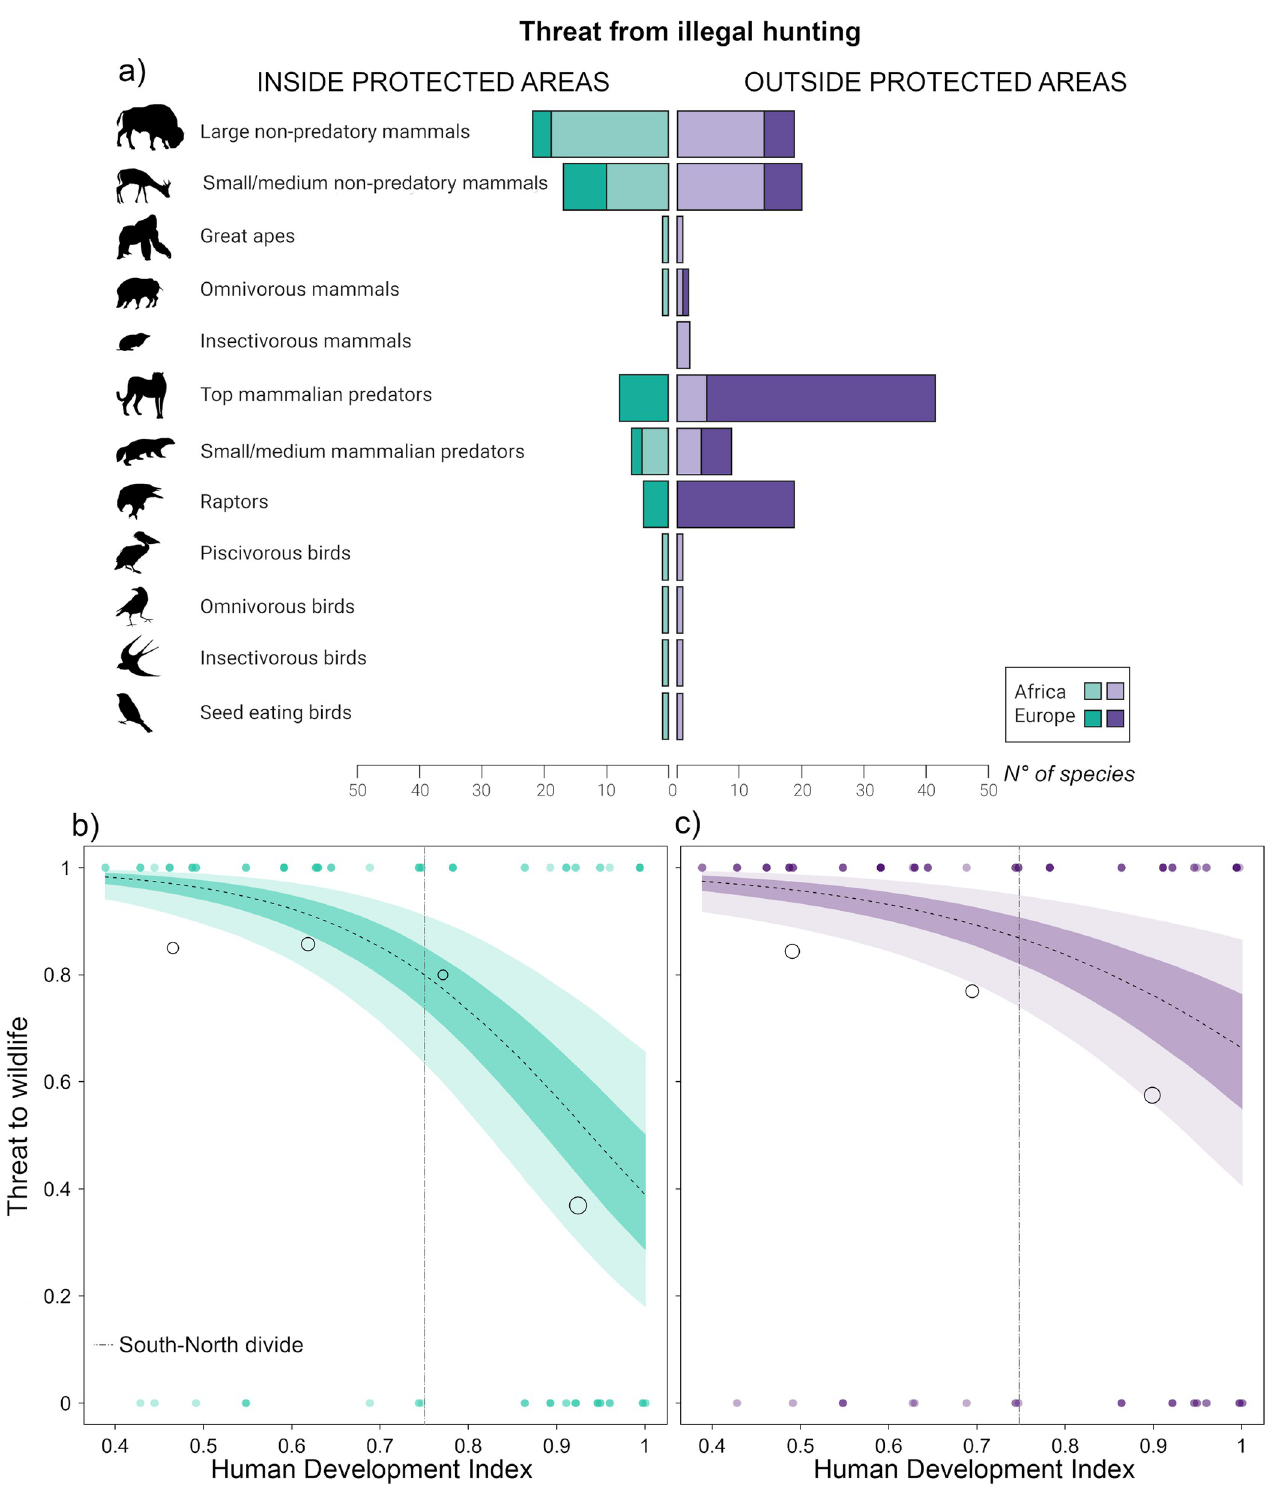
Fig 4. Where people hunt. (a) The absolute numbers of listed species of the PA threatened by illegal hunting within the administrative borders versus outside the park borders revealed higher threats for predators outside borders in Europe (darker colours) and higher threats for herbivores inside and outside parks in Africa (lighter colours). The probability that wildlife is threatened by illegal hunting (killing/hunting/poisoning) (the data underlying this figure can be found in S2 Data), (b) within the park boundaries (S8 Data) and (c) outside the park boundaries (S9 Data) decreased over the S-N gradient. Outside parks, the